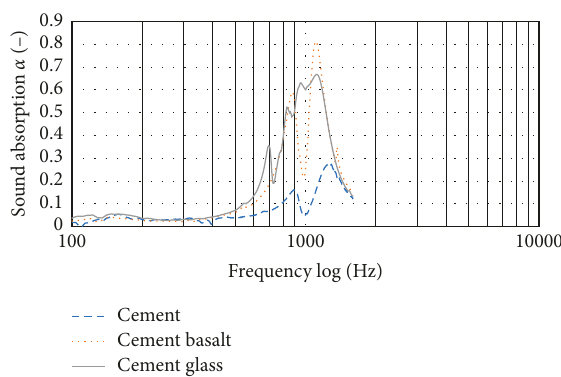
Figure 16: Absorption coefficient values obtained for